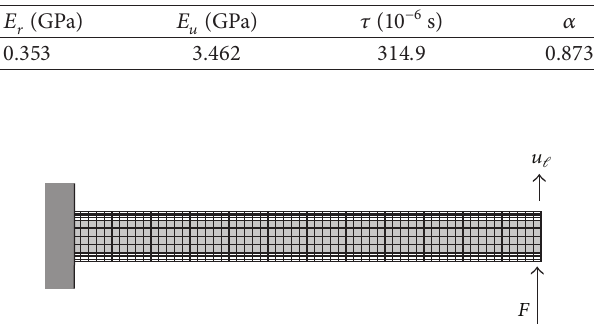
Figure 2: Finite element model for the 2D dynamical analysis of a sandwich